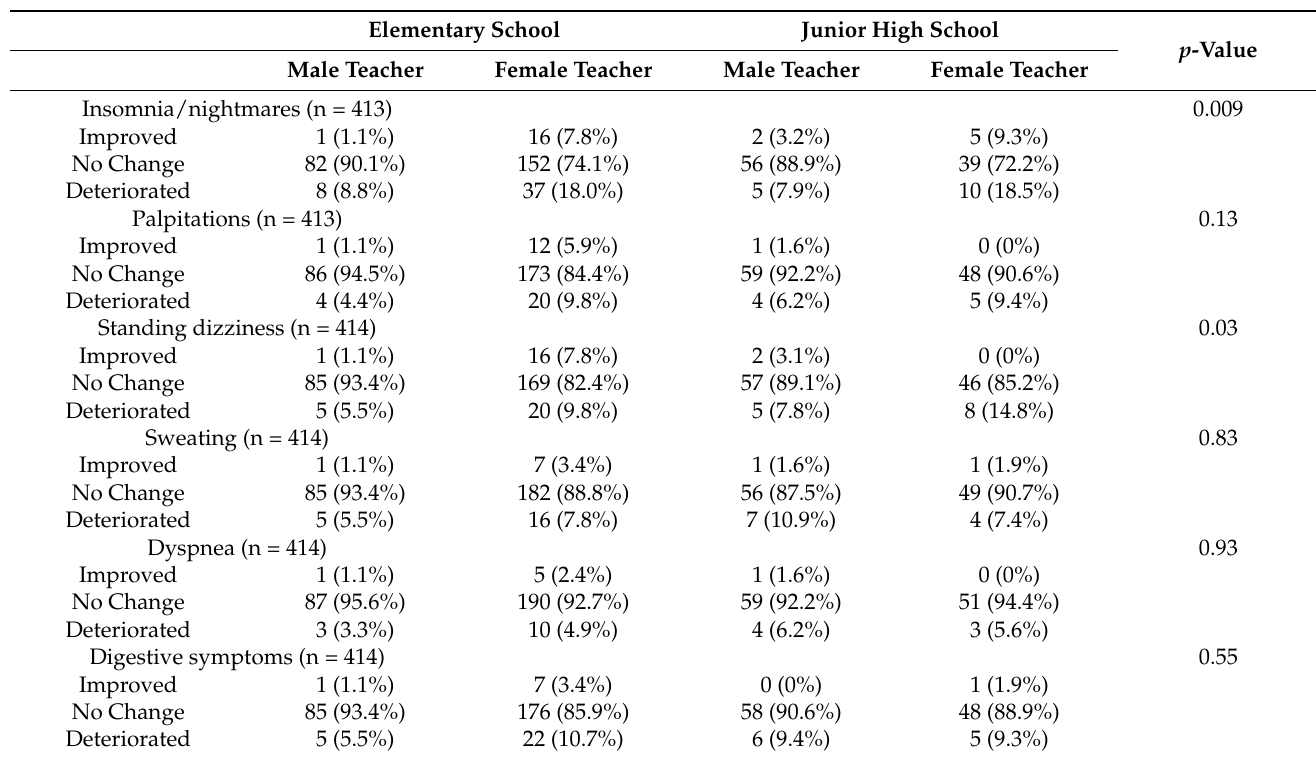
Table 3. Changes in physical symptoms before and after school closures due to